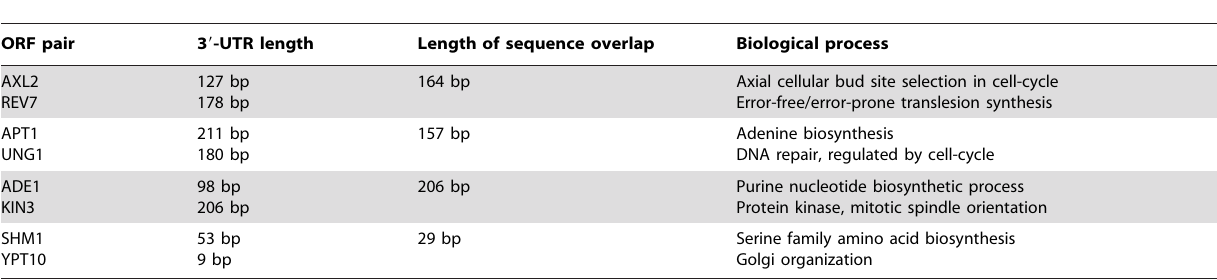
Table 1. Four convergent pairs of S. cerevisiae ORFs with overlapping 3 9 -UTRs.